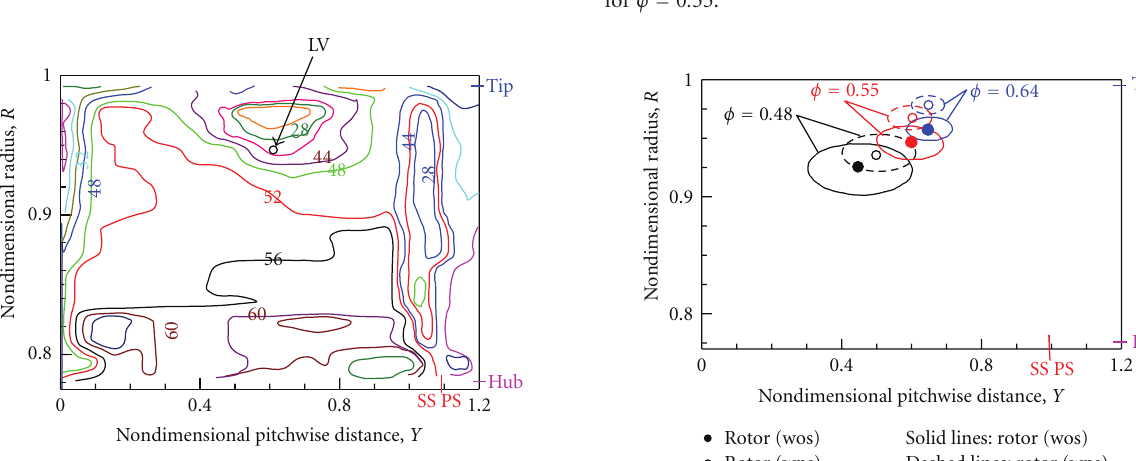
of low velocity region is absent in case of rotor (wps) config- uration. This is because the partial shroud attached to the tip from the pressure side to the suction side.